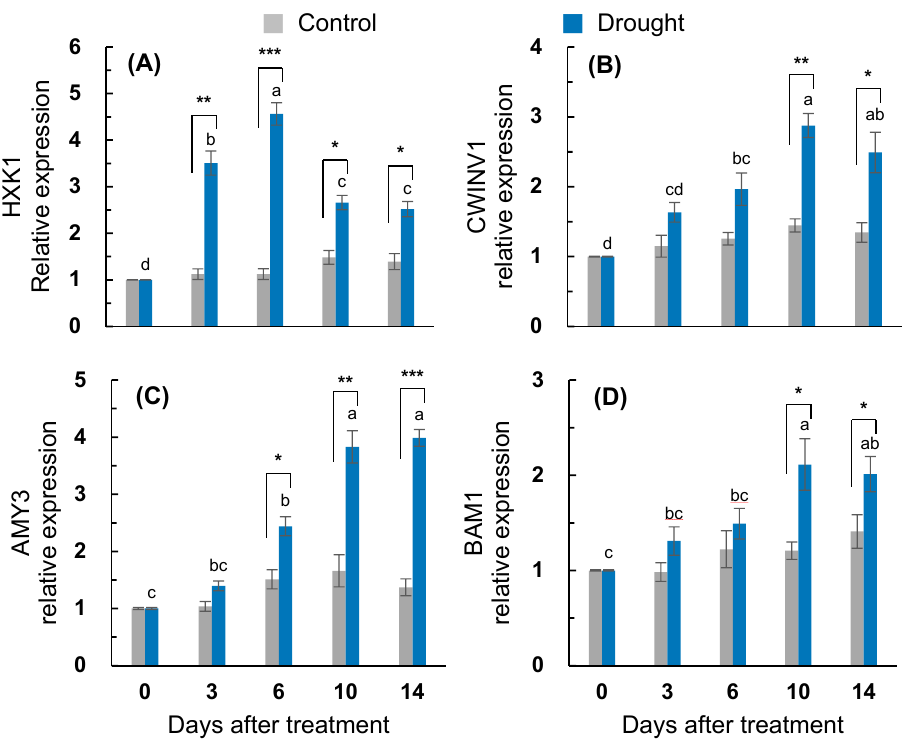
Figure 5. Changes in the relative gene expression of ( A ) hexose kinase 1 ( HXK1 ), ( B ) cell wall invertase 1 ( CWINV1 ), and starch degradation-related genes ( C ) α -amylase 3 ( AMY3 ) and ( D ) β -amylase 1 ( BAM1 ) in the leaves of the well-watered control or drought-stressed plants during 14 days of treatment. Data are presented as the mean ± SE from duplicates for each of the four independent plants. Bars labeled with different letters in the drought-stressed plants are significantly different at p < 0.05, according to Duncan’s multiple range test. Asterisks denote a statistical difference between the drought treatment and control: * p < 0.05, ** p < 0.01, and *** p < 0.001.